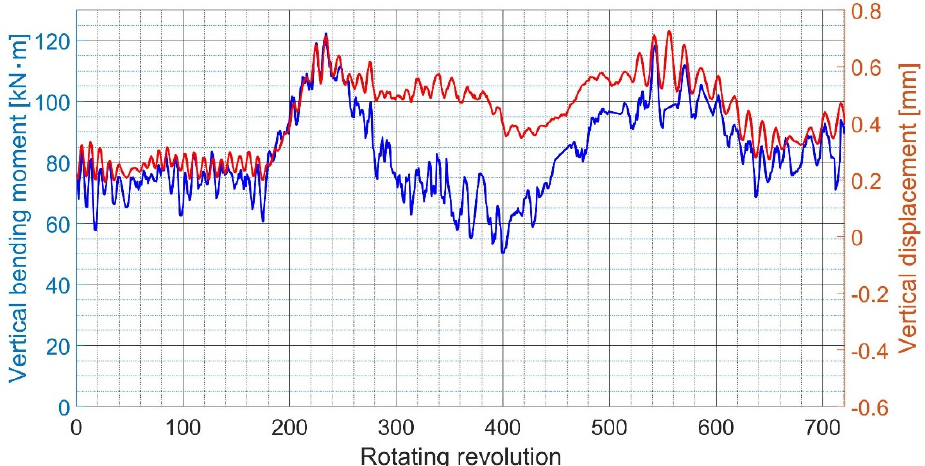
Figure 13. Bending moment during the starboard turn under the fully laden condition.